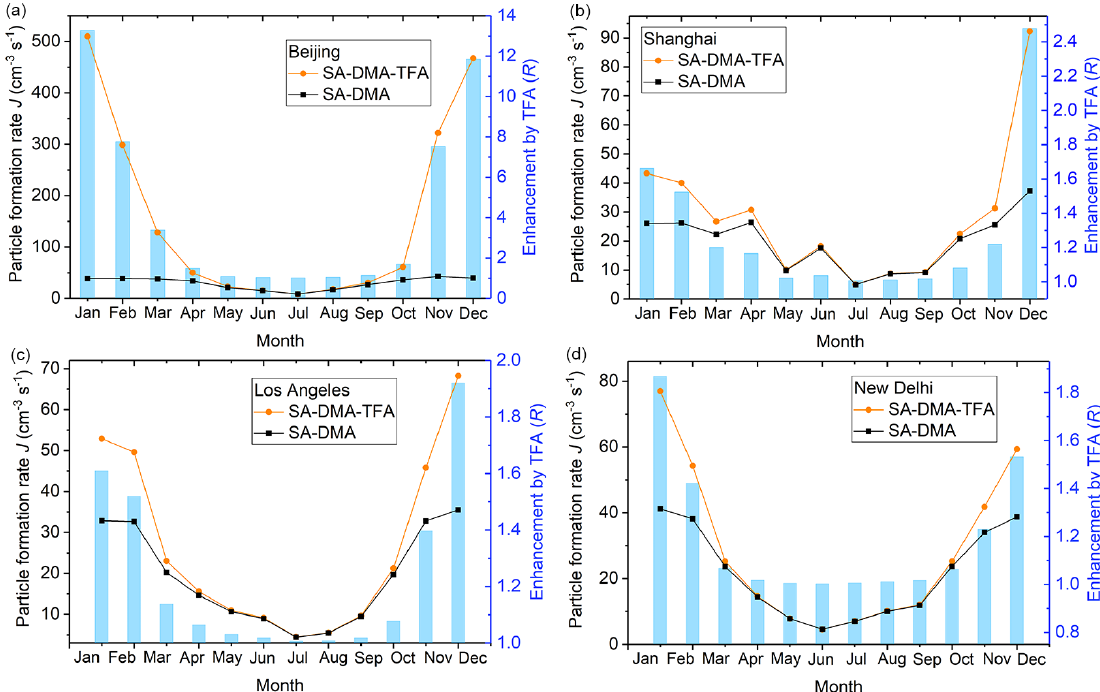
Figure 2. Particle formation rates ( J , cm − 3 s − 1 ) shown in orange circles (SA–DMA–TFA) and black squares (SA–DMA) and the enhance- ment on particle formation rates by TFA ( R , R = J SA-DMA-TFA /J SA-DMA ) shown in bar charts in (a) Beijing, (b) Shanghai, (c) Los Angeles, and (d) New